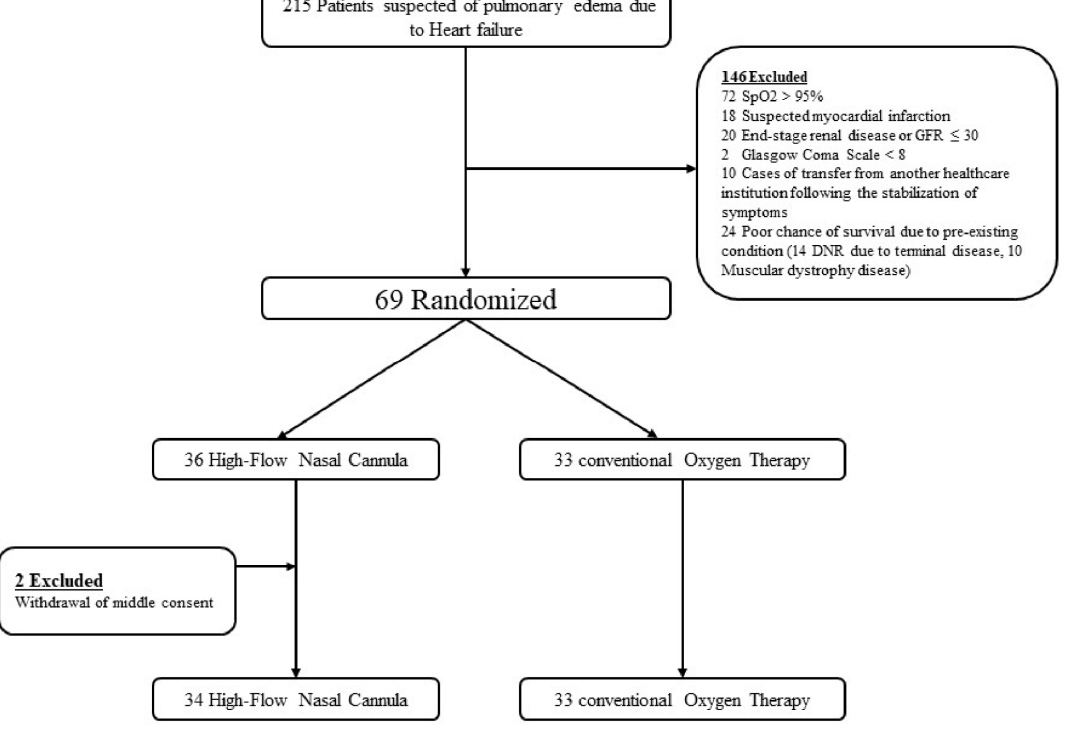
Table 1. Baseline characteristics of patients.